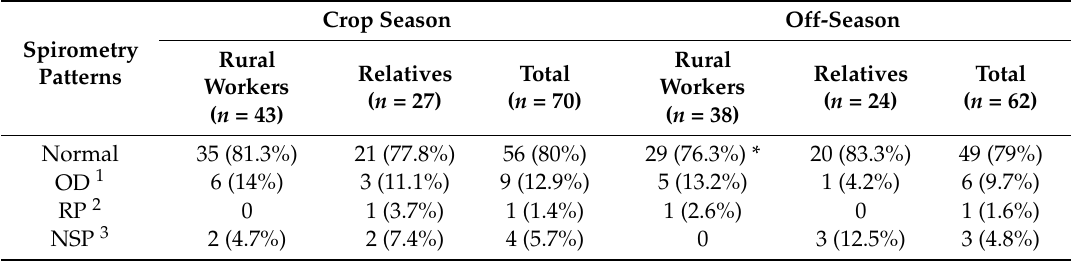
Table 3. Spirometry patterns among individuals assessed in SJU during crop season and off-season.